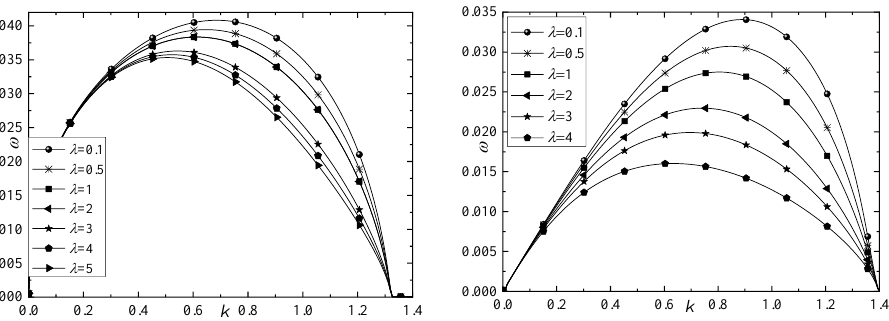
Figure 8. Effects of λ on sheet instability for sinuous and varicose modes.